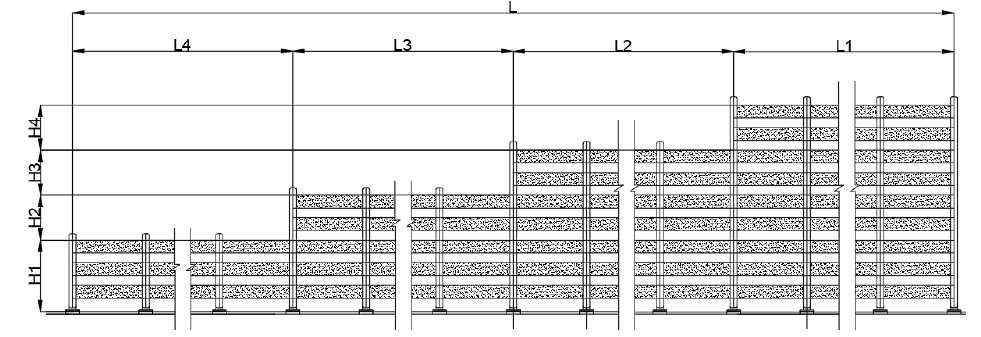
Figure 18. Wind barriers layout. Table 1. The concrete size of wind barriers (unit: